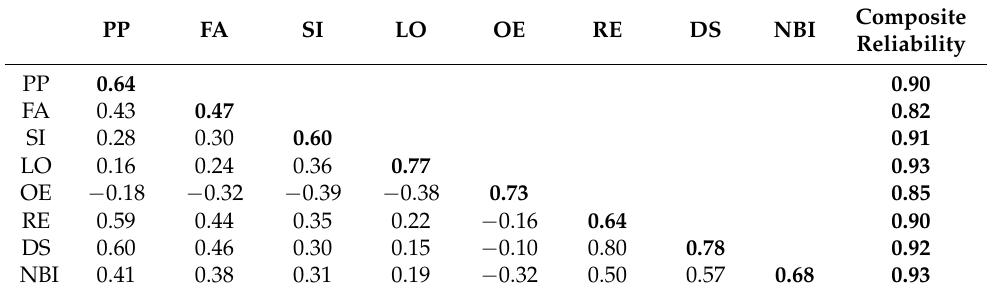
Table 3. Latent variable